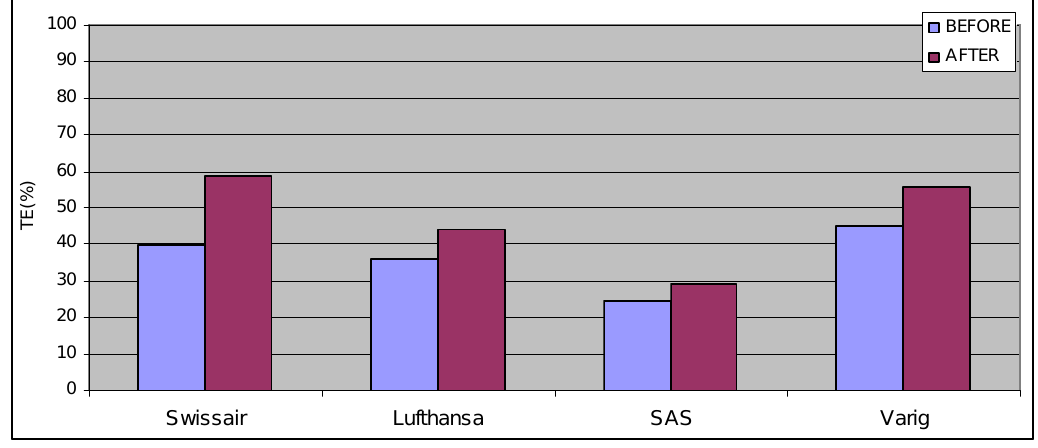
Figure 7. Average Technical Efficiency and Change of the State Ownership in